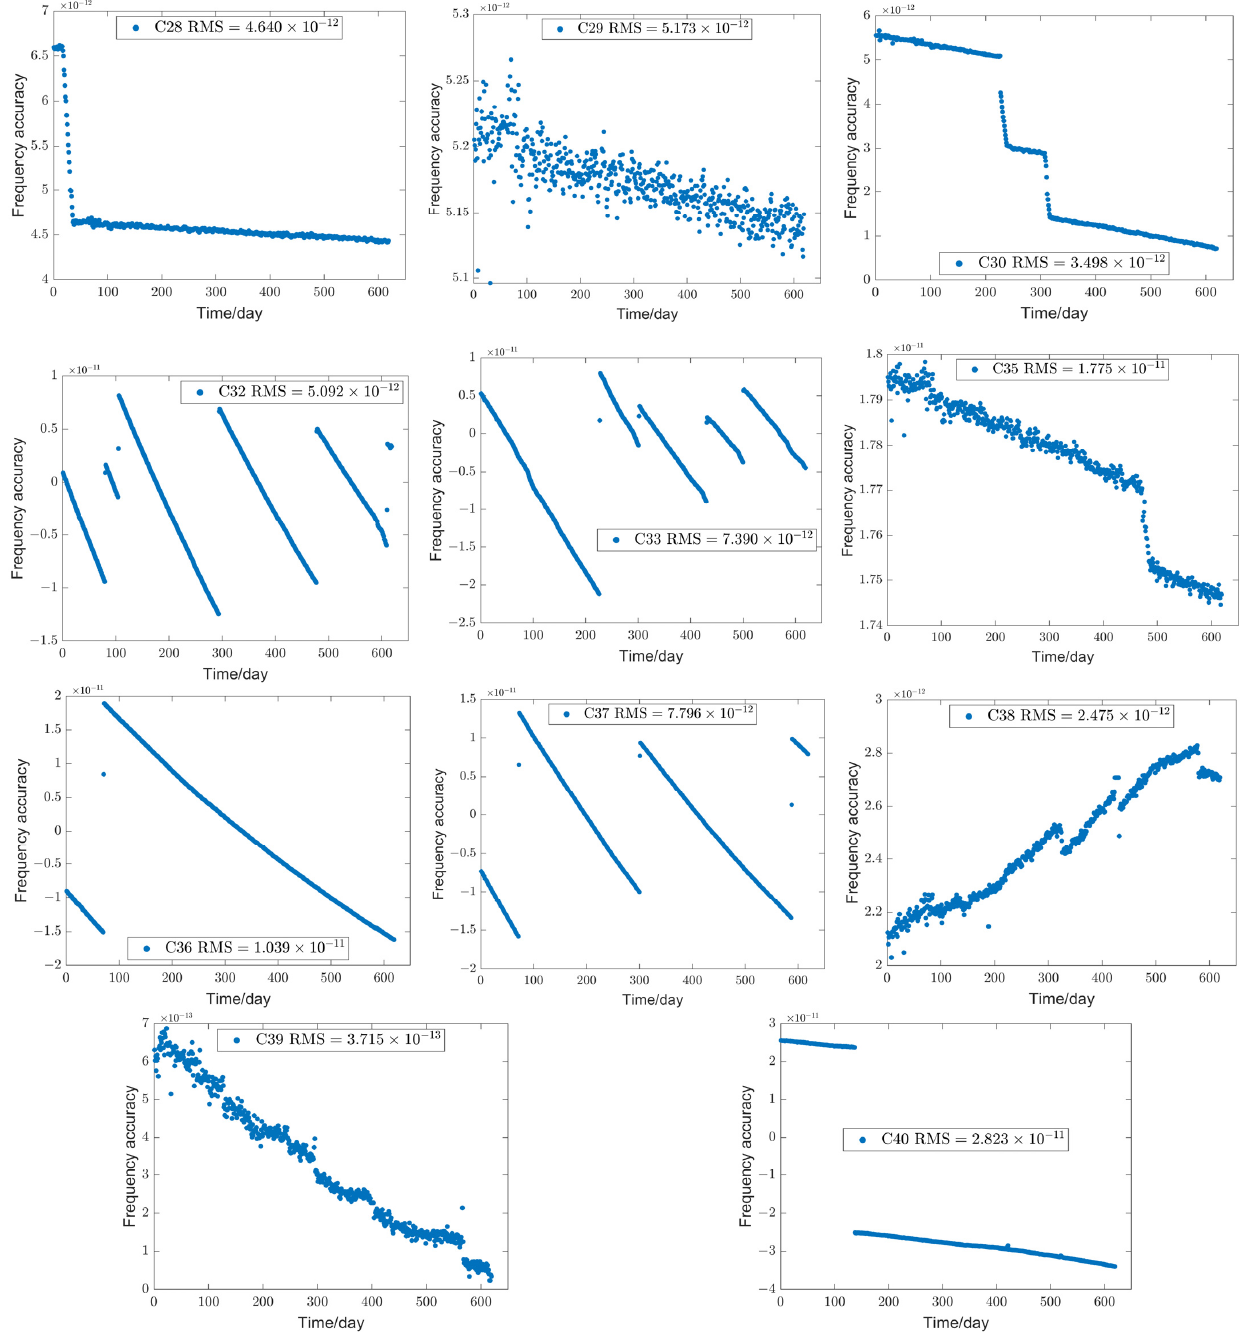
Figure 9. Frequency accuracy of BDS Satellites.